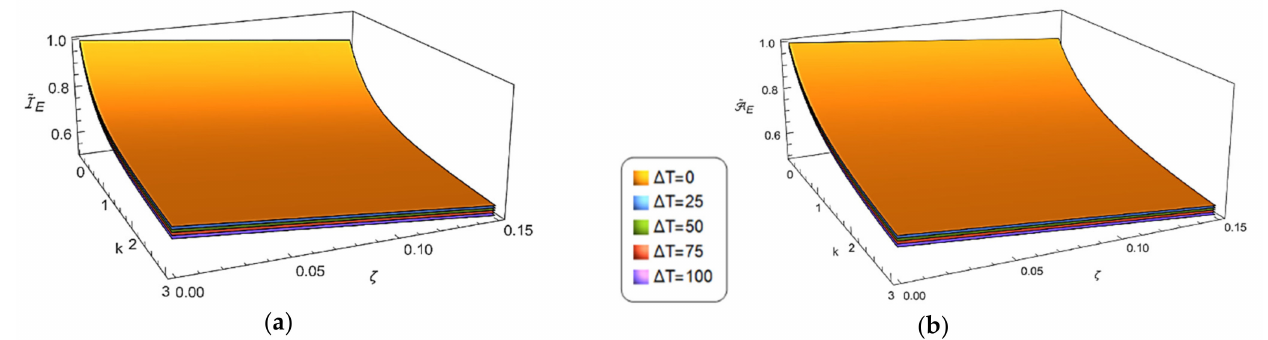
Figure 2. Combined effects of the gradient index ( k ) and the porosity volume fraction ( ζ ) on the dimensionless bending stiffness I E ( a ) and axial stiffness A E ( b ) under uniform temperature rises ( ∆ T = 0, 25, 50, 75, 100 [K]).